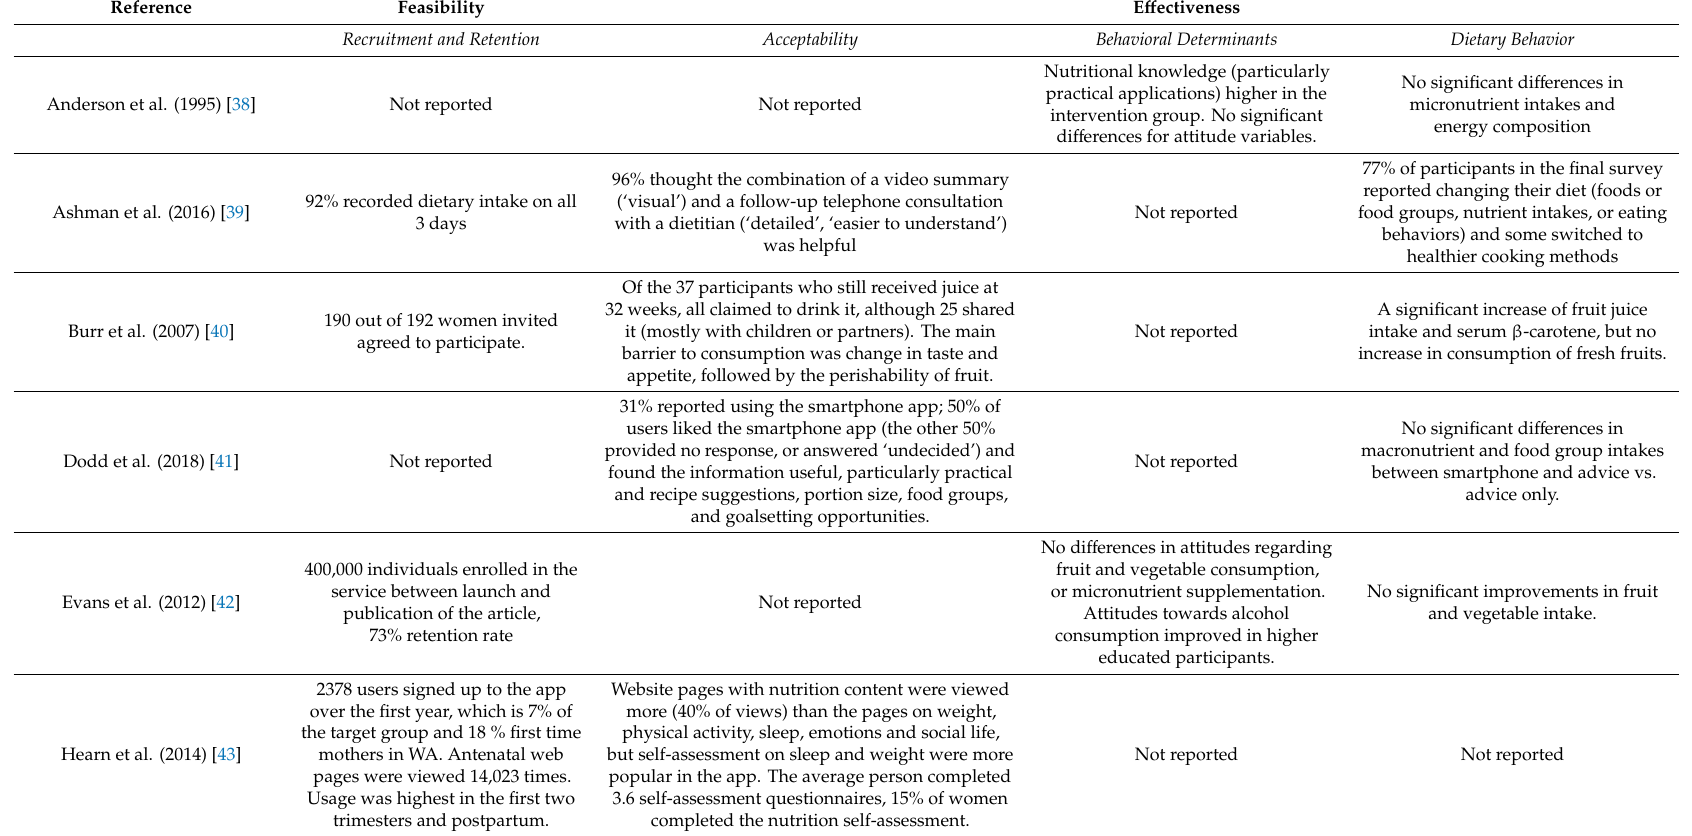
Table 4. Feasibility and e ff ectiveness outcomes